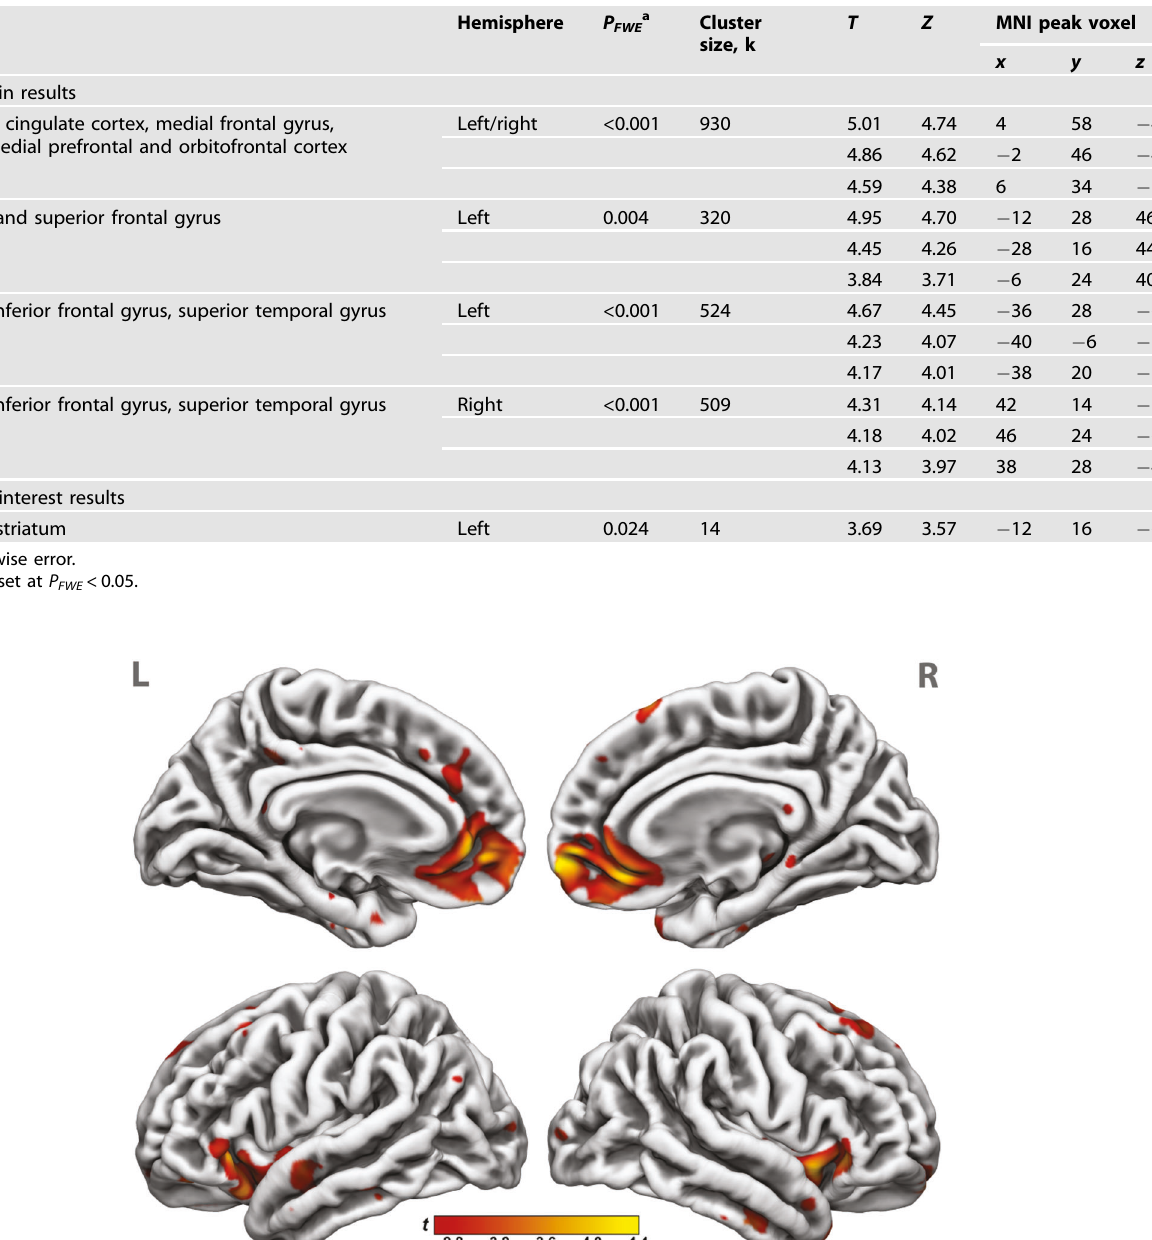
Fig. 1 Association between childhood maternal antipathy and neural activation to social reward anticipation. Note . Whole-brain analyses indicated childhood maternal antipathy was associated with decreased activation during social reward anticipation in the ventromedial prefrontal cortex, bilateral anterior insula, and superior frontal sulcus. The four clusters survived corrections for multiple comparisons at P < 0.001, uncorrected and k > 320 corresponding to P < 0.05, FWE correction. The t-map of the regression analysis controlling for age, sex, years of education, general psychopathology, and psychotropic medication load was thresholded at P < 0.005 for displaying purposes and the color gradient depicts the respective t -values of the maternal antipathy regression weights.